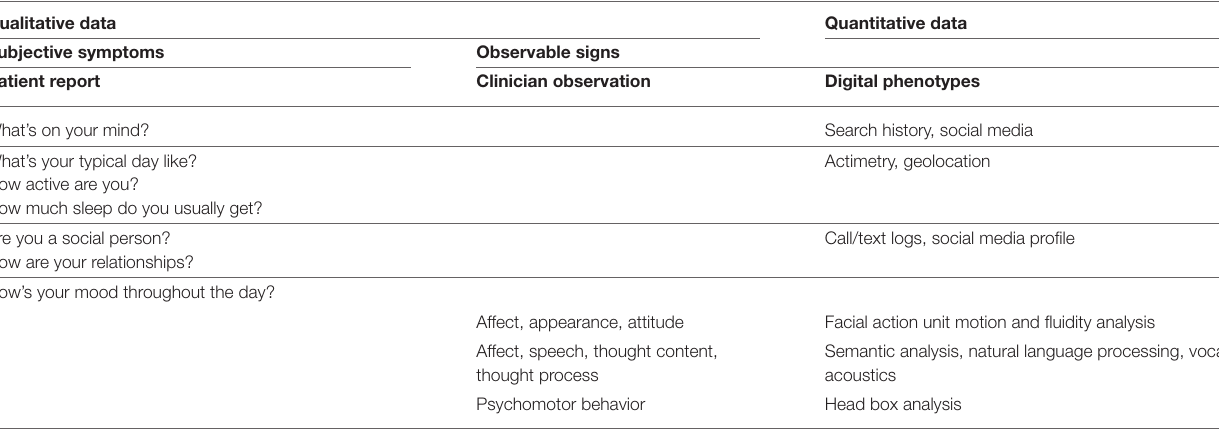
TABLE 2 | Digital phenotypes are quantitative observable